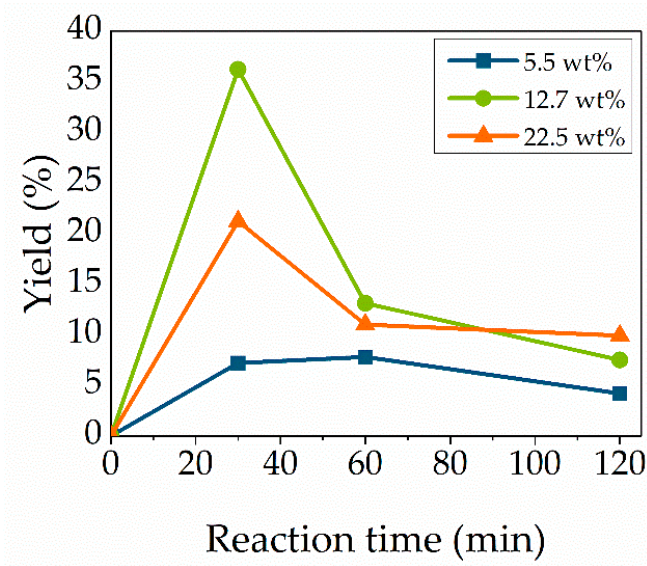
Figure 3 . Effect of enzyme concentration. Reaction conditions: cytidine (100 mg, 0.414 mmol), 1:35 molar ratio vinyl methacrylate, 95 °C and Novozym 435 5.5 wt% (blue), 12.7 wt% (green) or 22.5 wt% (orange). Lines are included as a guide to the eye.